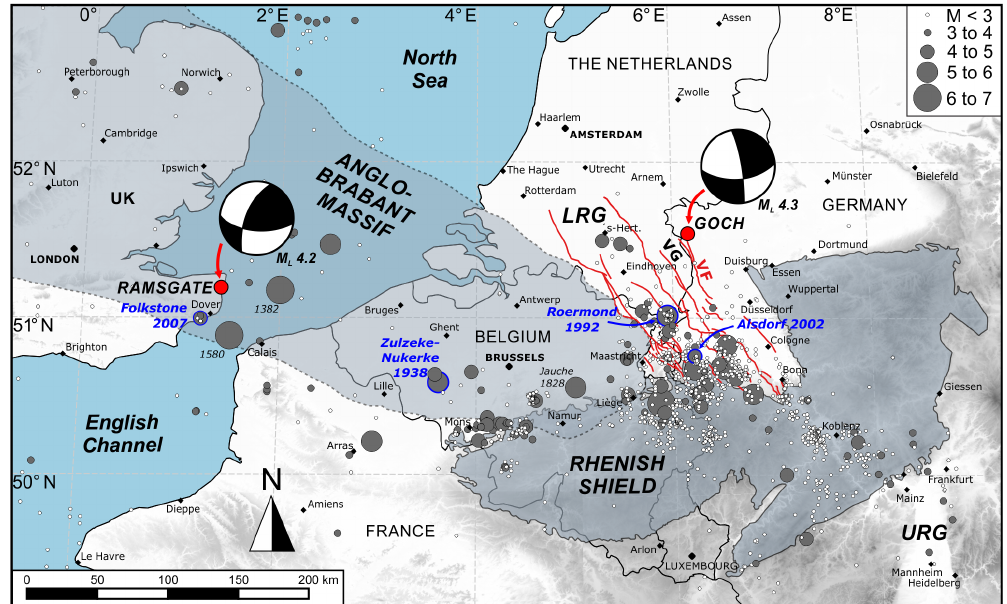
Figure 3. Combined ROB-BNS and BGS instrumental and historical seismic catalogues illustrated on the 30m SRTM-DEM (Shuttle Radar Topography Mission digital elevation model). The 2011 M L 4.3 Goch earthquake (red dot) occurred at the northeast end of the Venlo Graben (VG), close to the Viersen Fault (VF) in the northeast part of the Lower Rhine Graben (LRG). The 2015 M L 4.2 Ramsgate earthquake (red dot) took place offshore of the UK within the basement rocks of the Anglo-Brabant Massif, which extends from northern Belgium to the southeast UK. URG: Upper Rhine Graben. Macroseismic surveys of earthquakes indicated in blue are discussed in the